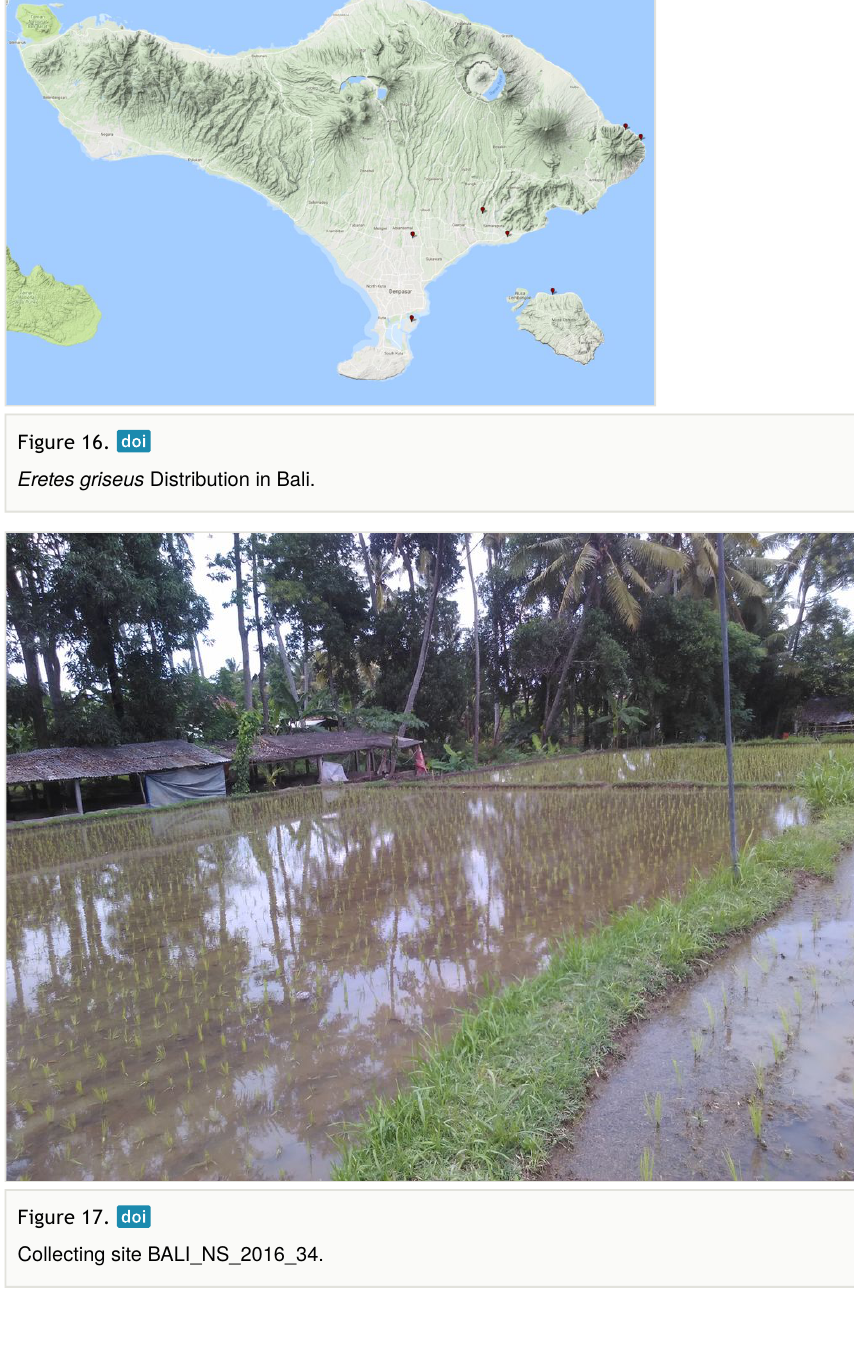
Figure 17. Collecting site